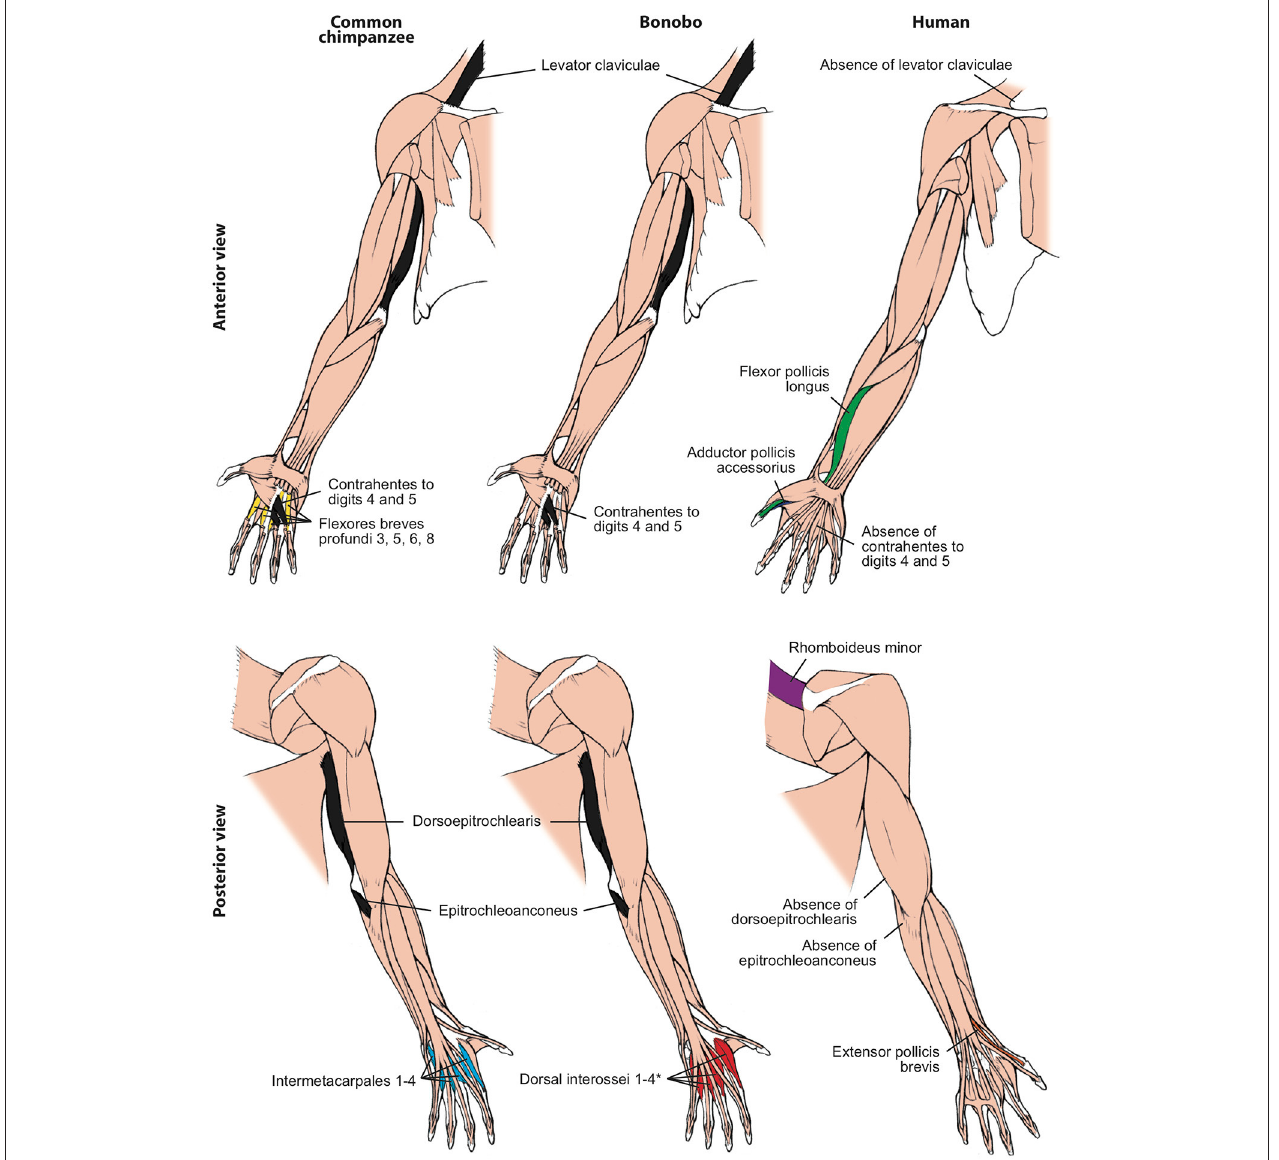
FIGURE 2 | Differences between forelimb muscles of common chimps, bonobos and humans, based and modified from Diogo et al. (2017b). The only consistent difference between bonobos (center) and common chimps (left) concerning the presence/absence of muscles (shown in colors in the common chimps and bonobos schemes) is that in the former the intermetacarpales 1–4 are usually fused with the flexores breves profundi 3, 5, 6, and 8 to form the dorsal interossei muscles 1–4 (* in bonobo) figure, as is the case in humans. In contrast, there are many differences between bonobos and humans (right) concerning the presence/absence of muscles (shown in colors and/or with labels in the human scheme; muscles present in chimps and not in humans are shown in black, in chimps). Modified from Diogo et al. (2017b); © Diogo has copyright of these